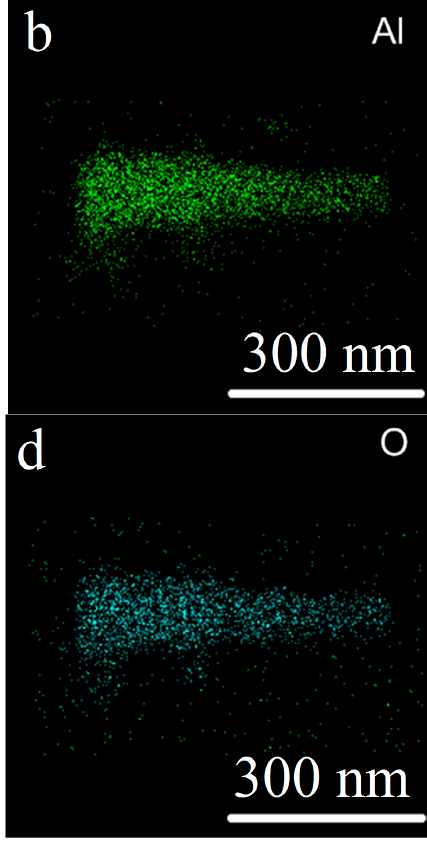
Figure 5. TEM image ( a ) and TEM-EDS mapping ( b – d ) of the nanoscale structures obtained through the water oxidation of Al/Ag nanoparticles at 80% RH at 60 °C (sample 2).